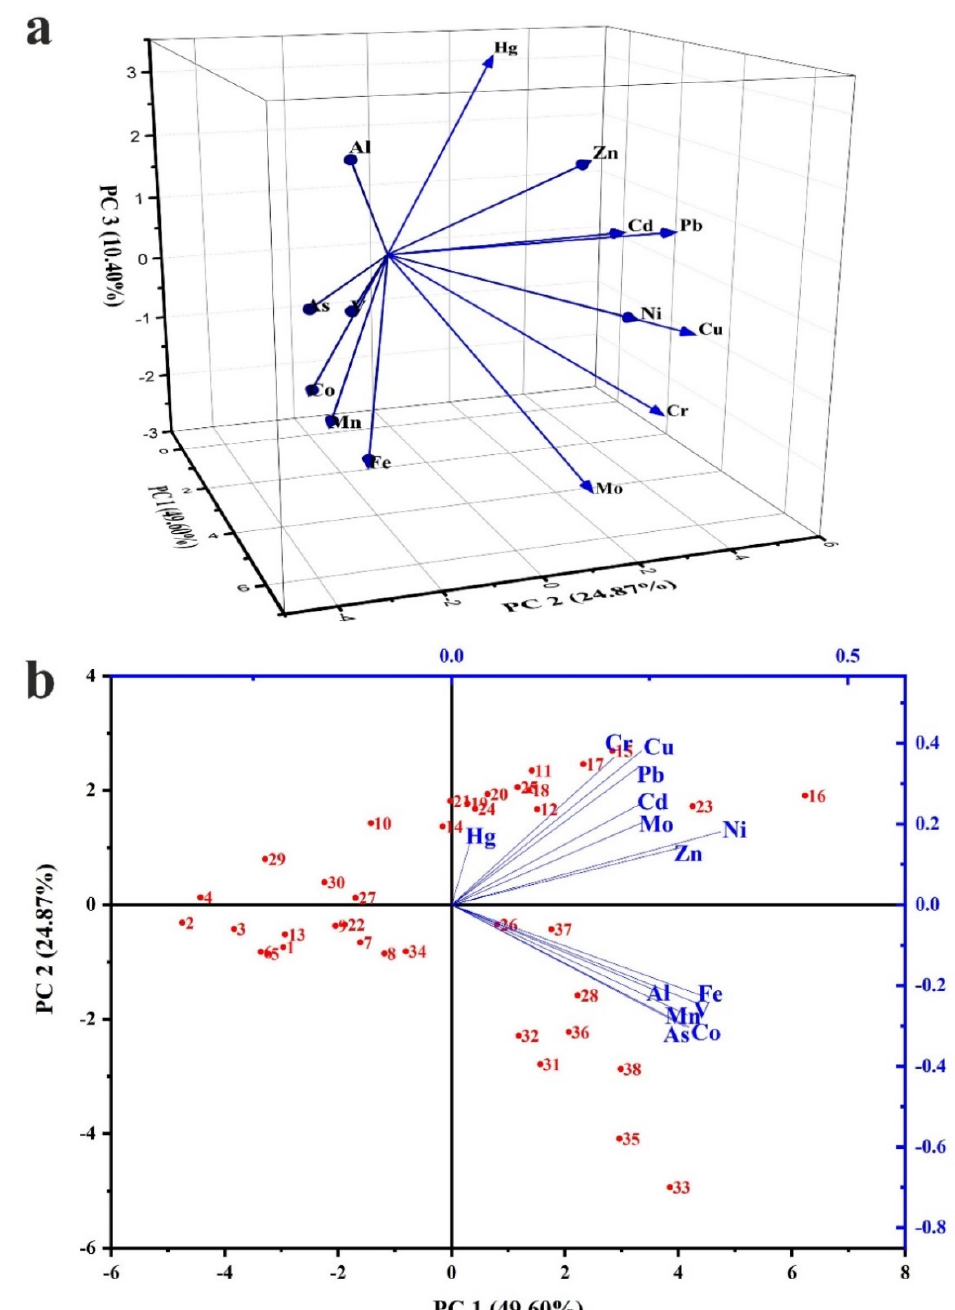
Figure 6. ( a ) PCA variable loading: 3D loading between the extracted 3 components; ( b ) 2D loading between PC1 and PC2 combined with sampling sites .